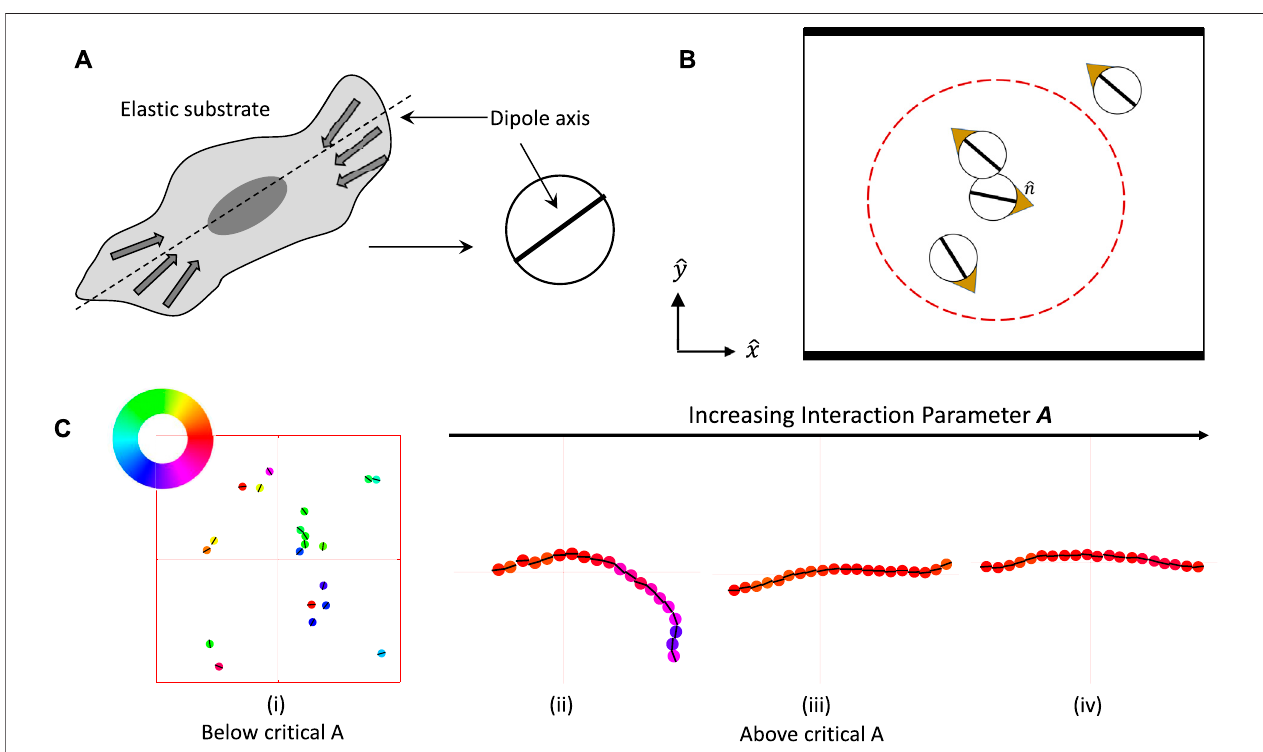
FIGURE 2 | Overview of agent based simulations of active Brownian particles (ABPs) moving in the x - y plane and interacting mechanically via elastic deformations induced by contractile, active force dipoles. (A) An elongated cell with traction forces distributed around its long axis is modeled as a disk-like particle endowed with a dipole moment. (B) Each ABP has a dipole axis represented by the bold black line and an in-plane self-propulsion direction represented by the gold arrow. These particles move on a linearly elastic, thick, fl at substrate, on which they exert contractile dipolar stresses. Substrate deformation due to one particle is sensed by neighboring particles. These dipole-dipole elastic interactionsare con fi ned toparticleswithin acutoff distance r cut = 7 σ (shown as thedashed red circle). Particle overlap is penalized by a short range steric repulsion. They are con fi ned by steric repulsions along the top and bottom walls shown by the thick lines, while being free to move through periodic boundaries shown by the thin lines. (C) for fi gure (i)Simulation snapshotshows that weakly interacting particles do not stick toeach other and move as independent entities. As the elastic dipolar interaction parameter A increases, the particles self-assemble into long chains ((ii)-(iv), zoomed view shown). The fl exibility of the chainsand fl uctuationsinthemean curvatureboth decrease withincreasingvalues oftheinteractionparameter. The colorsrepresent theself-propulsion directionof each particle, as indicated by the color